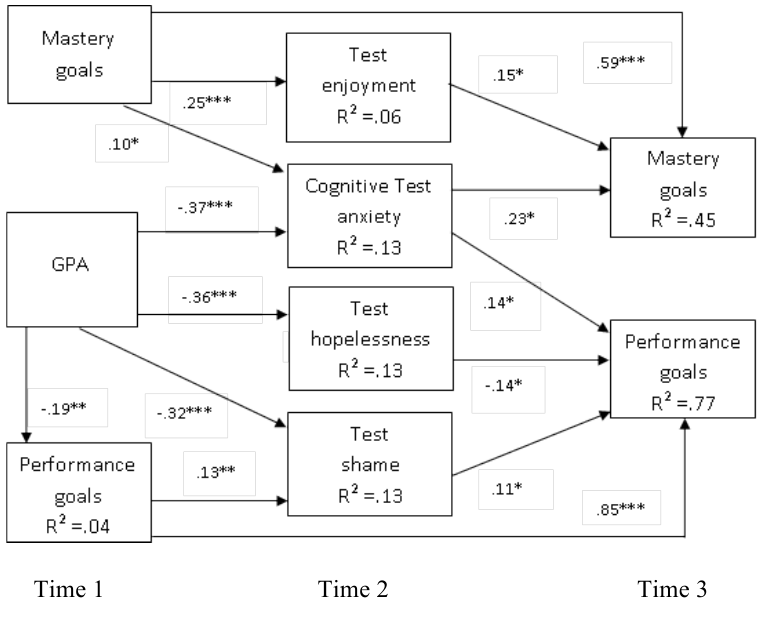
Figure 2. Standardized model for achievement goals and